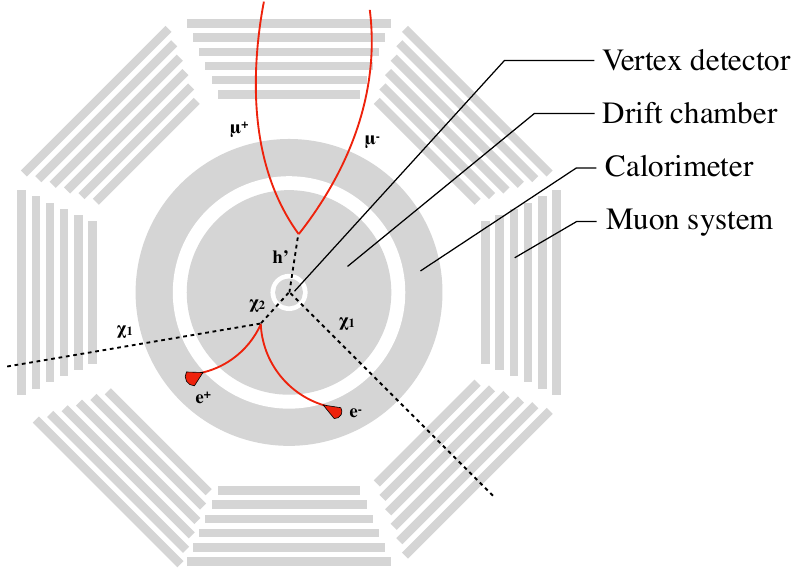
Figure 2 . Schematic view of the Belle II detector ( xy -plane) and example displaced